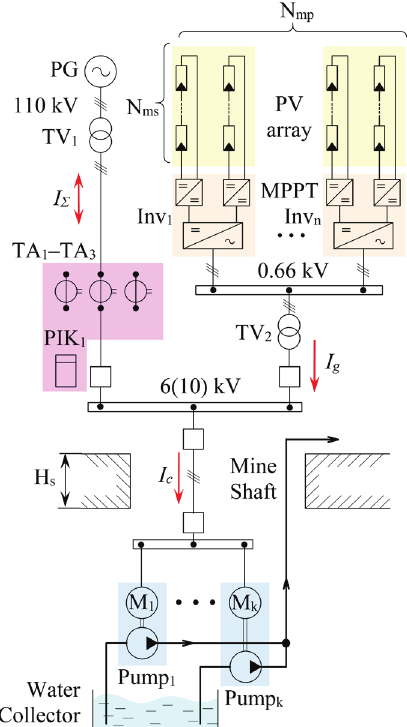
Fig. 1 . Single-line diagram of a microgrid for mine dewatering equipped with a photovoltaic station